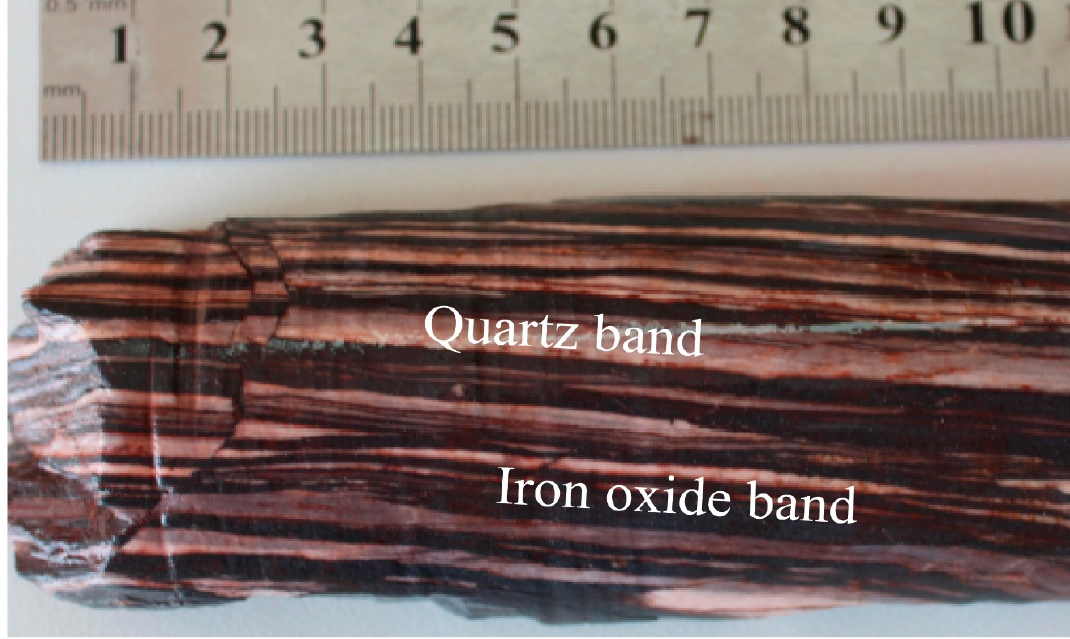
Figure 6. Hand-specimen photos of the itabirite, showing the alternation of iron oxide-rich bands and quartz bands.